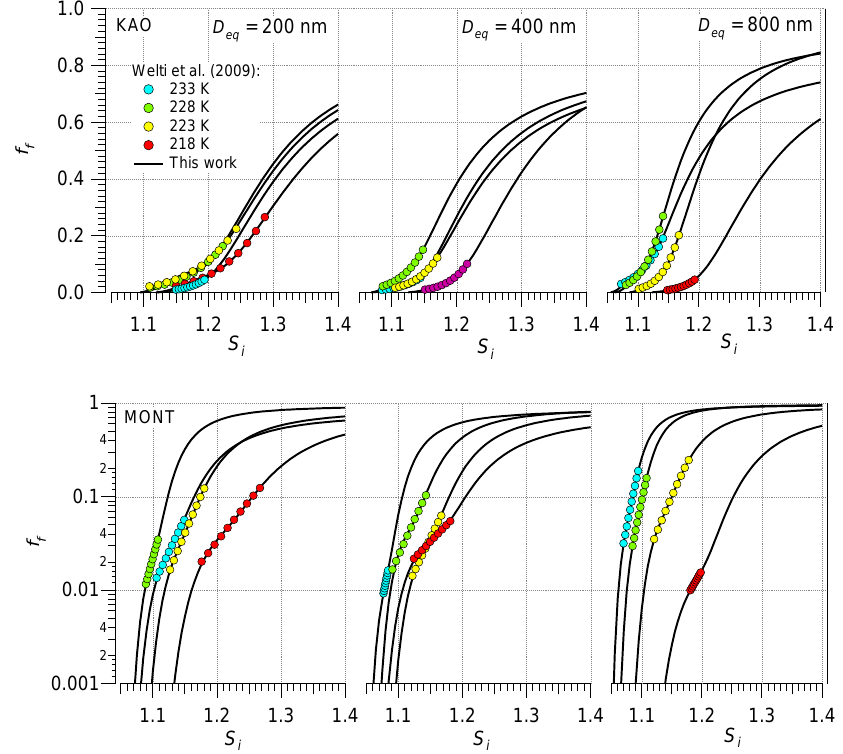
Fig. 6. Heterogeneous ice nucleation spectra in the deposition mode for Kaolinite (KAO) and Montmorillonite (MONT).